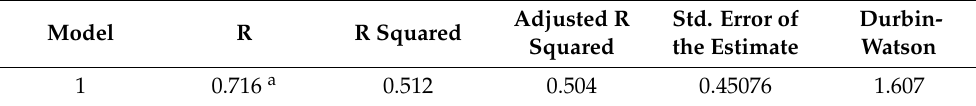
Table 8. Model Summary b